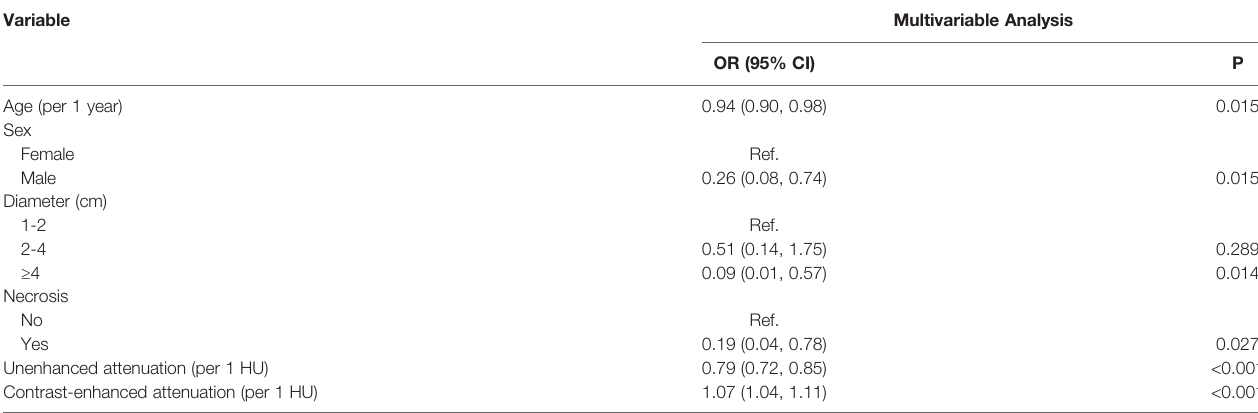
TABLE 2 | Results of multivariate analysis for features selected by LASSO algorithm.